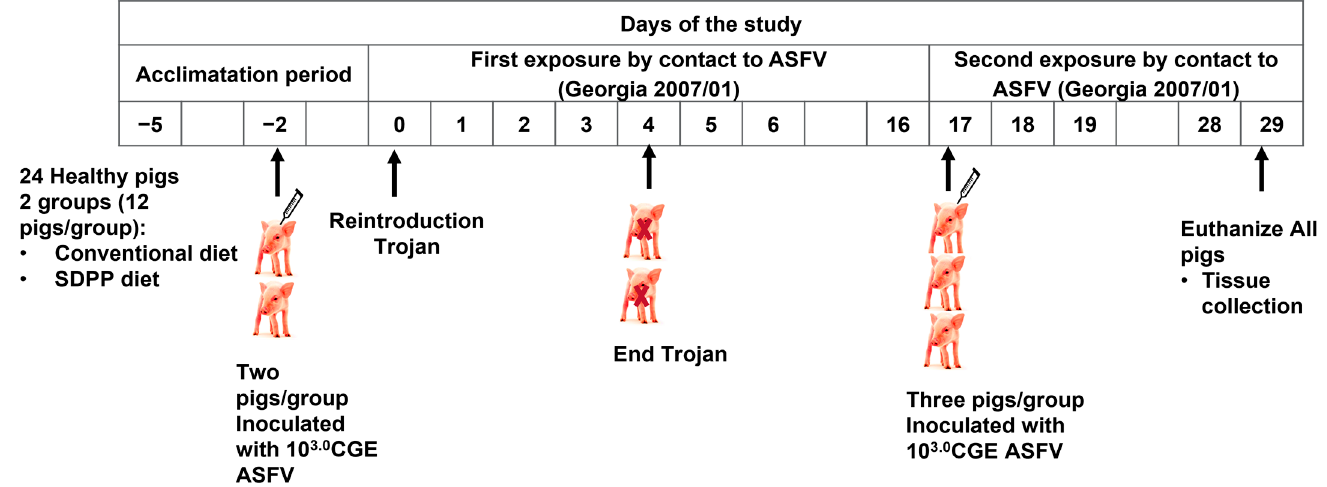
Figure 1. Schematic representation of the study design.